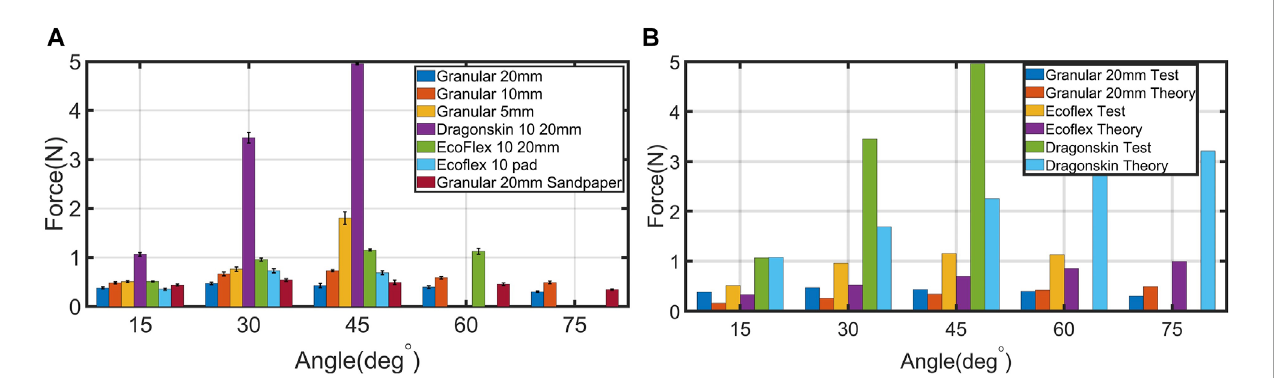
FIGURE 5 (A) Measured required force for adaptation to various angles. Since at 60 ° and 75 ° 5 mm granular, Dragonskin 10 and Ecoflex 10 pad suction cup could not attach to surface, the values are not shown. (B) The measured value of the adaptation force and the required force calculated from the theory. The stiffness of different cases was calculated using the measurements shown in Figure 7 . Similar to (A) , the missing data are for the cases that suction cup could not attach. The standard deviation of each experiment is shown with error bar.